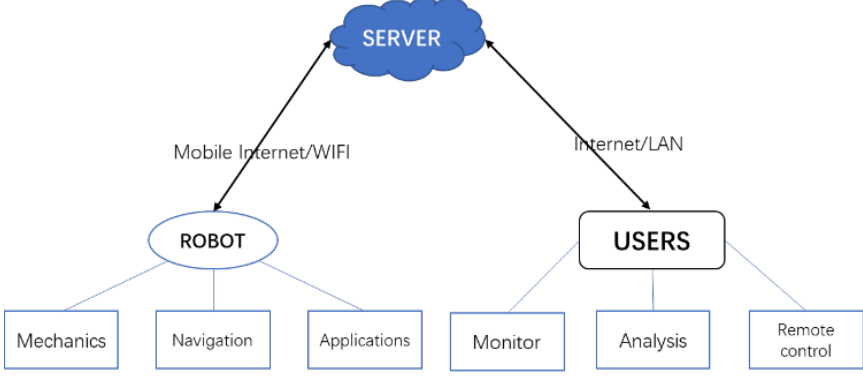
Figure 1. General design scheme for a dam surveillance robot.